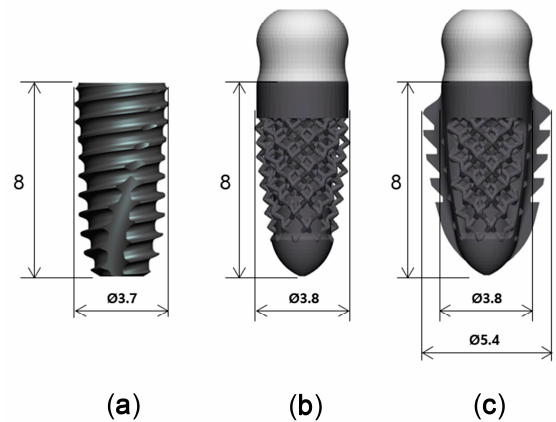
Figure 2. Three implants with different designs. ( a ): SuperLine Fixture (FXS 36 08); ( b ): 3D-printed implant without spikes; ( c ): 3D-printed implant with spikes.